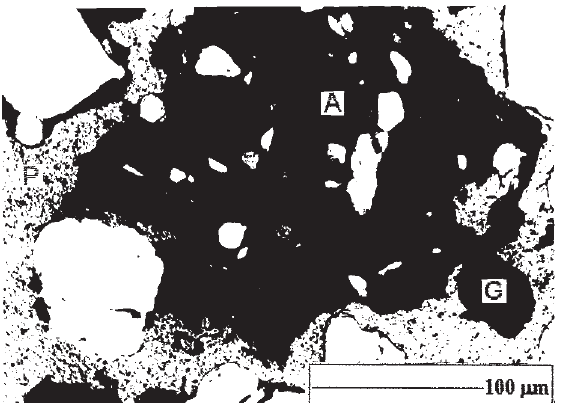
Figura 13. Preenchimento de poros com argila iluvial no horizonte BA do perfil com dois anos de cultivo